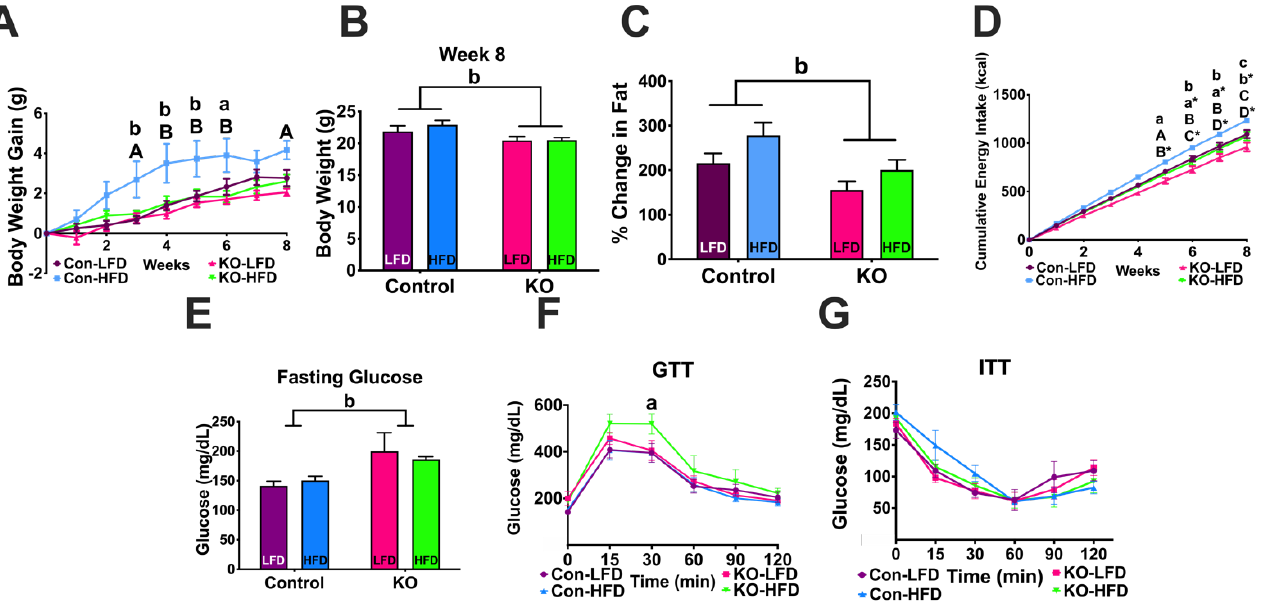
Figure 4. Response to HFD for intact control and Kiss1-GHSR KO (KO) female mice fed LFD or HFD for 8 weeks. ( A ) Weekly body weight gain and ( B ) Week 8 body weight. ( C ) Percent change in fat mass and ( D ) Weekly cumulative energy intake (kCal). ( E ) Fasting (5 h) glucose levels in whole blood, ( F ) Glucose tolerance test (GTT) and ( G ) Insulin tolerance test (ITT). For ( A , D ): lowercase